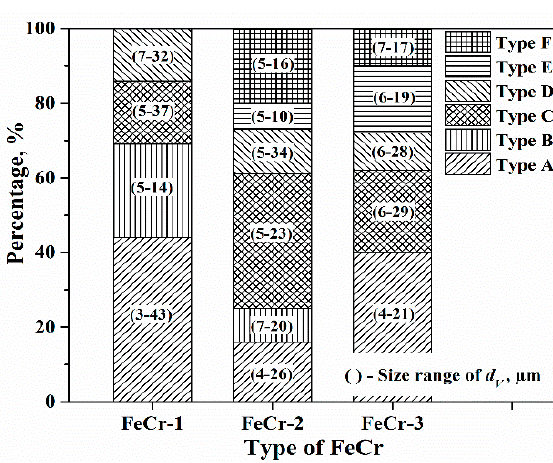
Figure 5. Frequencies and size ranges of different types of inclusions in three different FeCr alloys.